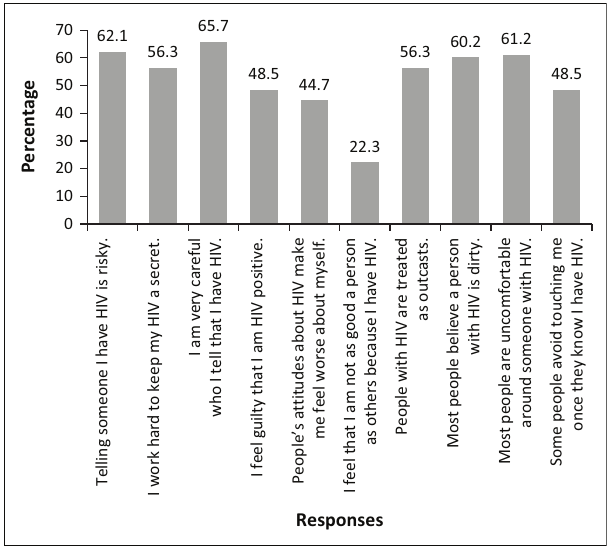
FIGURE 1: Participant responses to HIV Stigma Scale items. Bars represent the percentage responding ‘strongly agree’ or ‘agree’ to individual items.